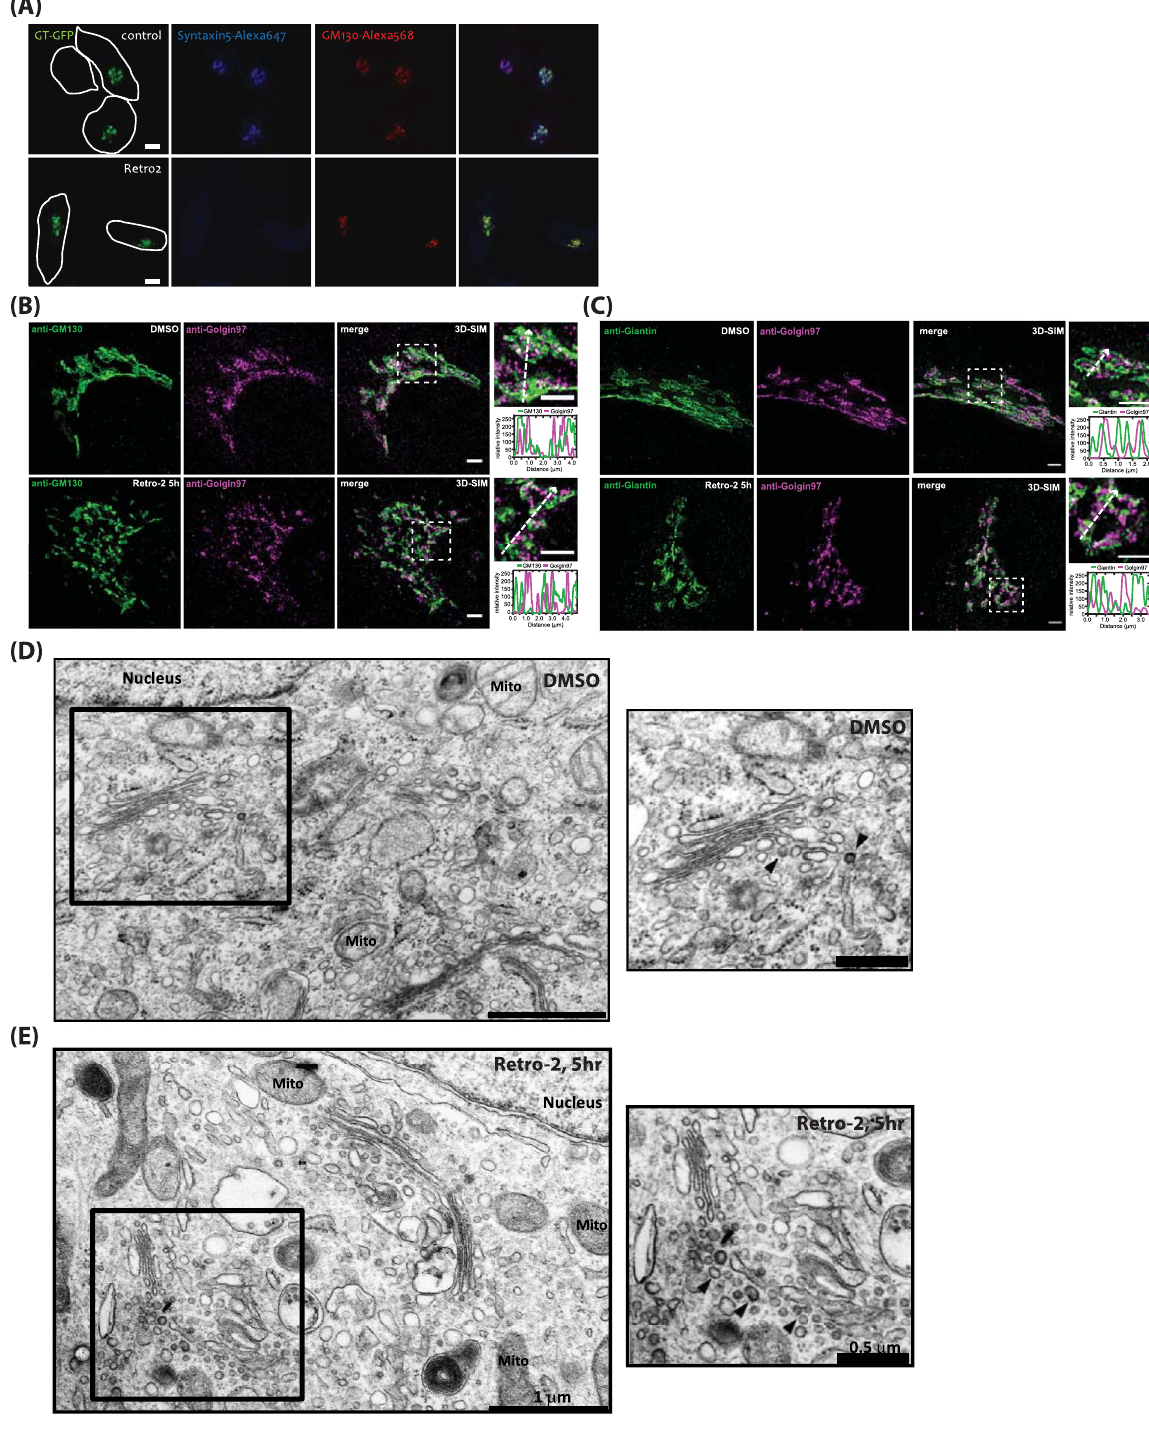
Figure 1. Acute displacement of Syntaxin5 by Retro-2 results in significant turnover of Golgi membranes to vesicular profiles, accumulated in peri-Golgi area. ( A ) Retro-2 treatment re-distributes Syntaxin5 from the Golgi within ~ 5 h. Confocal micrographs showing that Syntaxin5 is largely absent at the Golgi in HeLa cells treated with 25 μM Retro2 for 5 h. Golgi markers, GT-GFP and GM130, did not show any noticeable change in Retro2-treated cells. (scale bar 10 μm). ( B , C ) 3D-SIM images of the Golgi, stained with anti-GM130 ( cis -Golgi) and anti-Golgin97 ( trans -Golgi) or anti-Giantin (Golgi rim) and anti-Golgin97 antibodies in cells treated with either DMSO (control) or 25 μM Retro-2 for 5 h. Note that Golgi ribbon structure still localized to perinuclear region in both DMSO and Retro-2 treated cells (scale bar 2 μm). ( D , E ) Representative EM photos showing accumulation of vesicular profiles in Retro-2-treated cells. We observed striking amount of vesicular profiles in Retro-2-treated cells, but failed to notice any significant Golgi disassembly or cisternal dilation, as often observed in GRASP or Golgin knockdown experiments. M mitochondria, N nucleus, G Golgi apparatus (scale bar 1